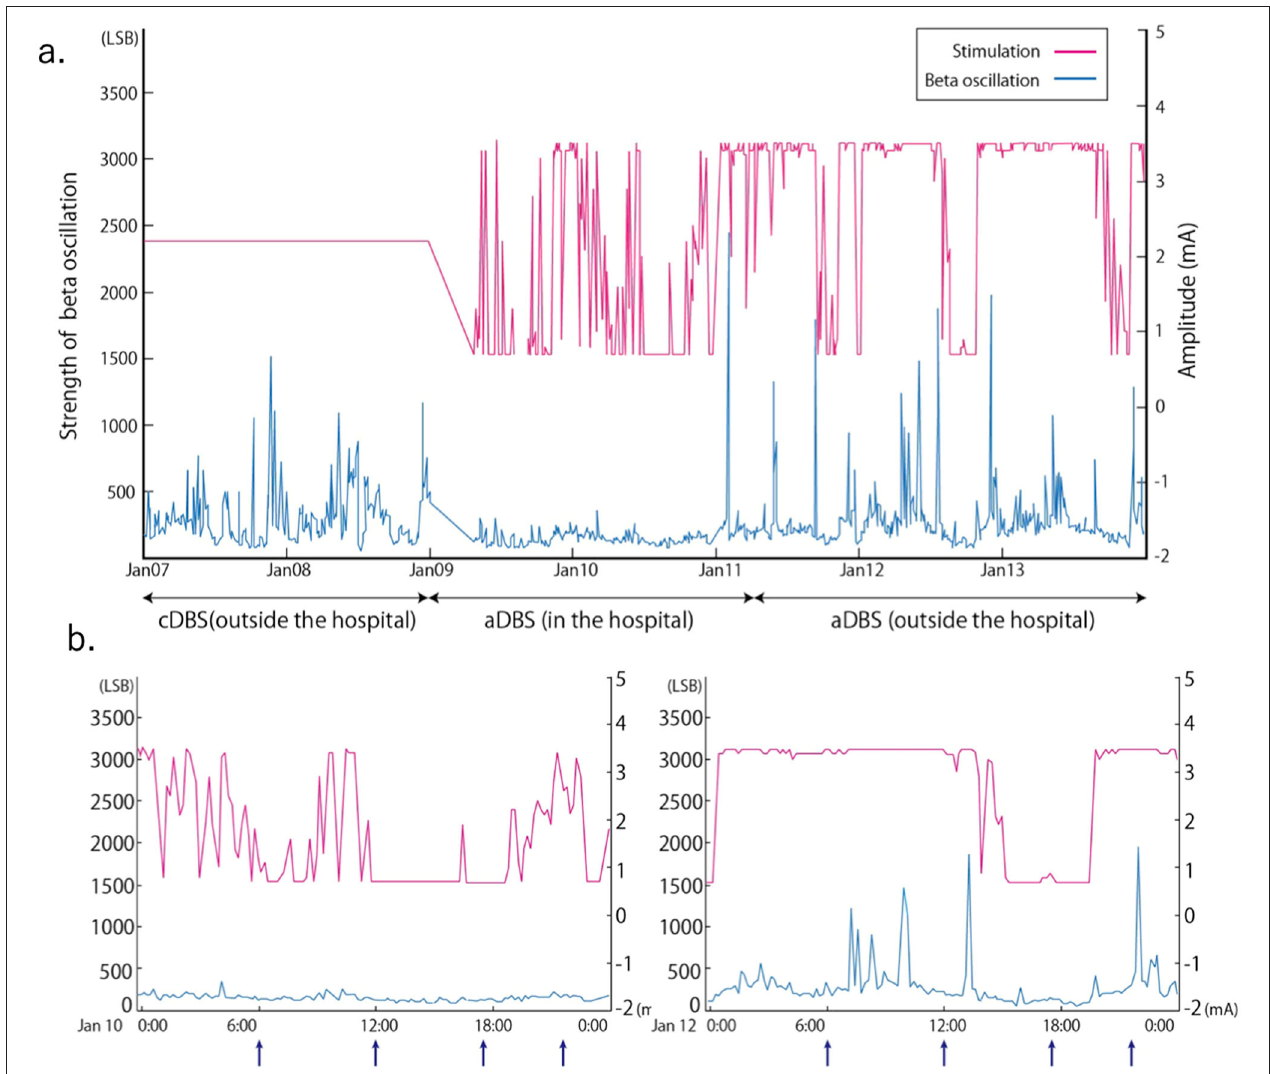
FIGURE 2 | Stimulation amplitude of adaptive deep brain stimulation (aDBS) and fluctuations in the beta band (16.60 ± 2.5Hz) oscillation of the local field potential (LFP) over time for a long period (a) and a short period (b) . Arrow in (b) indicates the timing of levodopa 100mg /carbidopa 25mg intake. Conventional DBS (cDBS) (outside the hospital): Stimulation was set at 2.2mA. aDBS (inside and outside the hospital): Upper stimulation was set at 3.5mA and lower at 0.7mA. Strength of beta oscillation = Vin (v) * Gain * 16 (LSB) / 1.2 (v) Vin: input voltage to the analog to digital convertor, Gain = 250, LSB of an analog-to-digital convertor is 16 least significant bits, The analog-to-digital convertor has a voltage range of